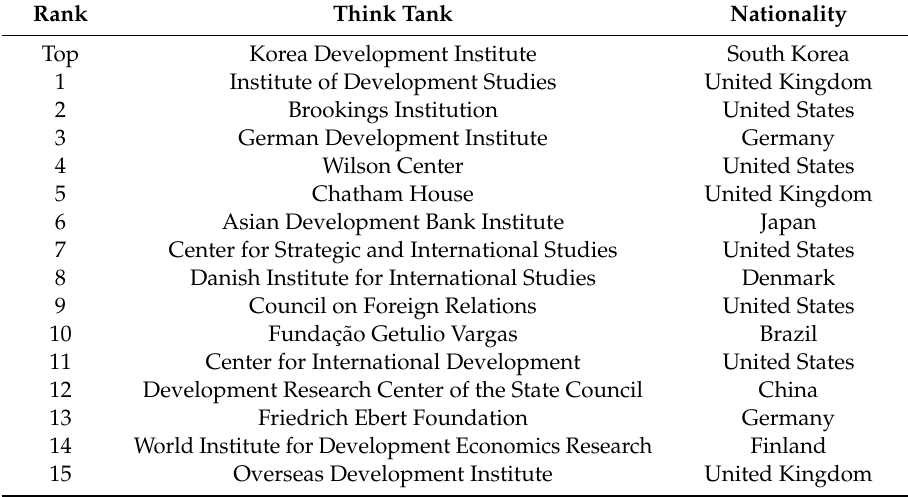
Table 1. Top 15 Think tanks in the category International Development